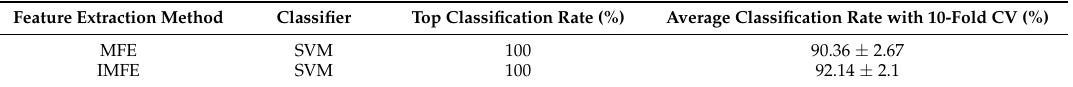
Figure 9. For =4 τ , the mean and standard deviation of FED curves for input variables ( a ) Figure 9. For τ = 4, the mean and standard deviation of FED curves for input variables ( a ) embedding embedding dimension m ; ( b ) boundary gradient n ; and ( c ) boundary width r . dimension m ; ( b ) boundary gradient n ; and ( c ) boundary width r . Table 2. The influence of parameter optimization in MFE on recognition rate. Feature Extraction